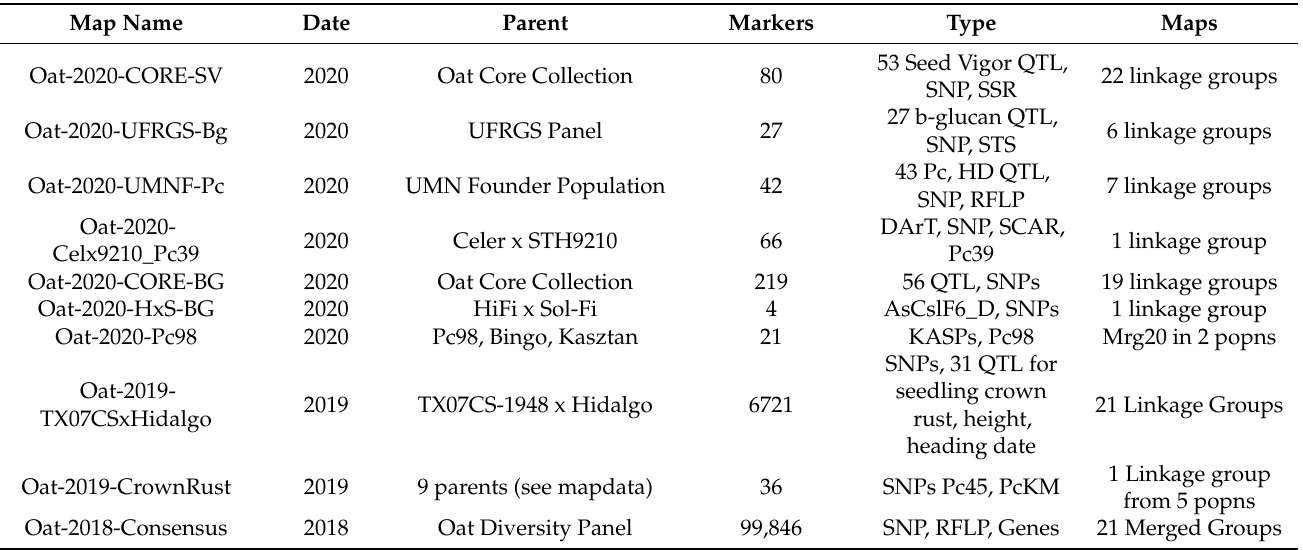
Table 3. Ten most recent Avena genetic map sets in GrainGenes available for using the CMap tool for comparative